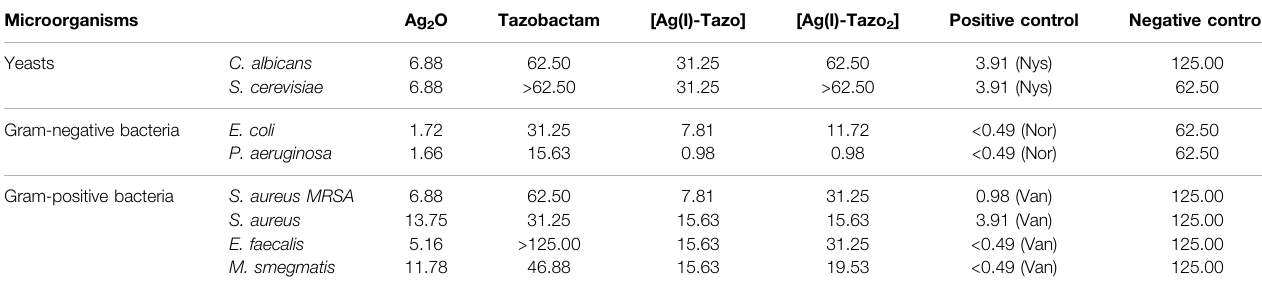
TABLE 2 | Determination of the minimum inhibitory concentration values (MIC, µg/mL) of the synthesized compounds, and the starting materials for Candida albicans and Saccharomyces cerevisiae (yeasts), Escherichia coli and Pseudomonas aeruginosa (Gram-negative bacteria) and Staphylococcus aureus , Enterococcus faecalis and Mycobacterium smegmatis (Gram-positive bacteria) after 24 h for bacteria and 48 h for